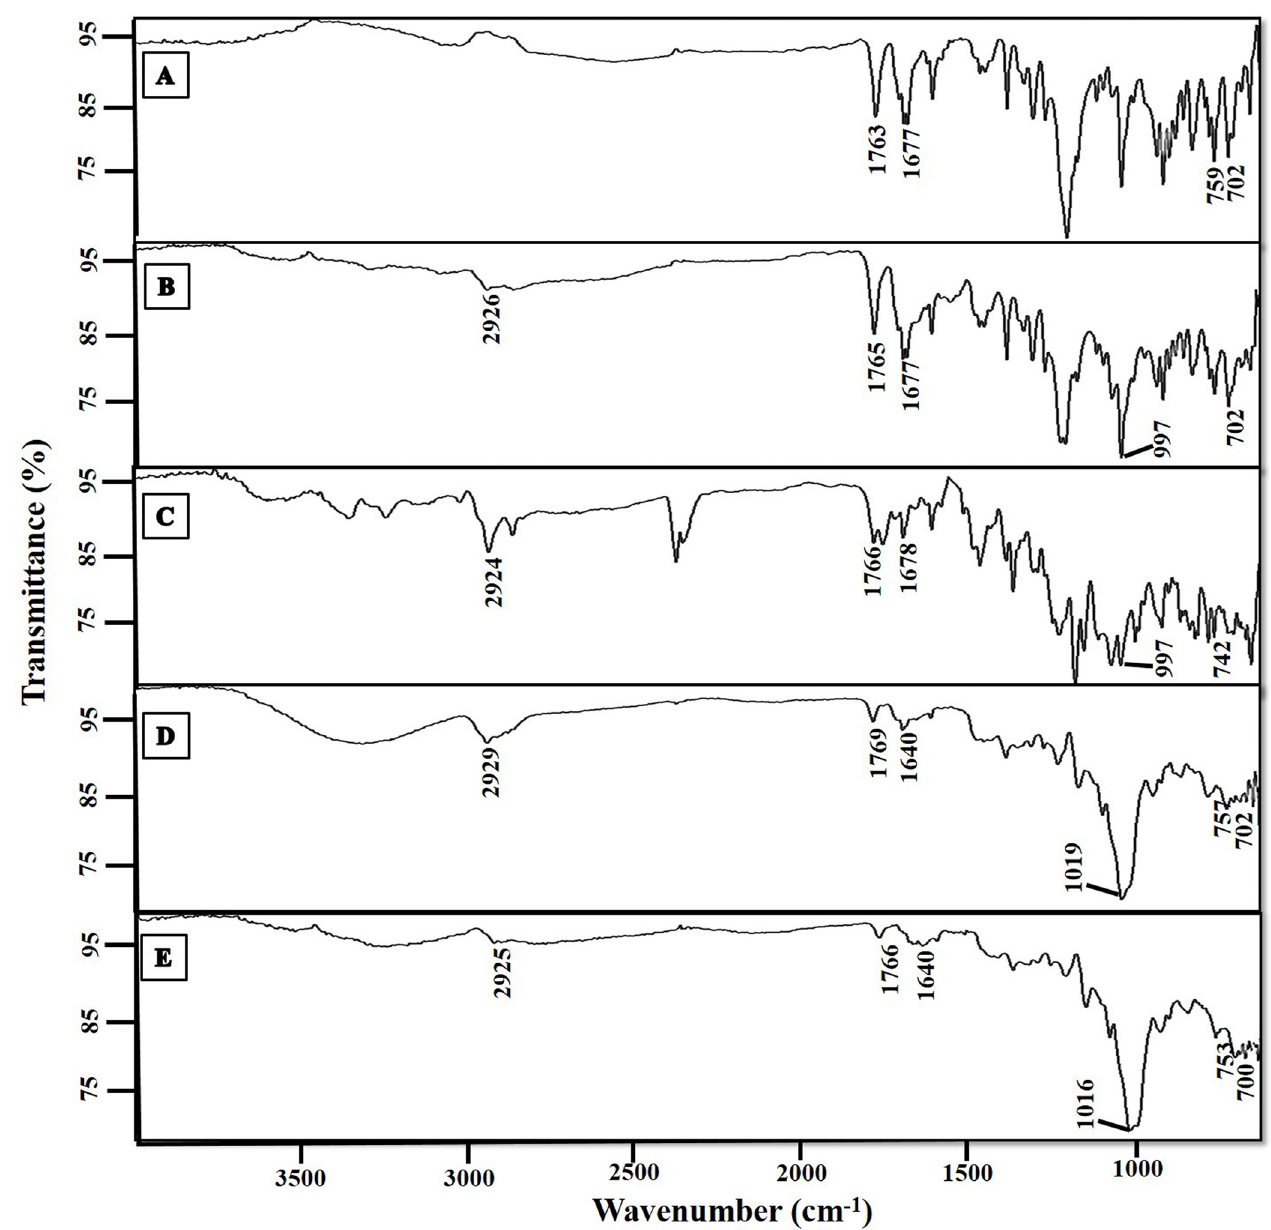
Fig 2. FTIR analysis of diacerein (A), egg lecithin based physical mixture (B), soy lecithin based physical mixture (C), D5PL (D) and D11PL (E). lecithin based physical mixture showed peaks at 2924 cm -1 (2921cm -1 of lipid), 1766 cm -1 (1763 cm -1 of diacerein), at 1678 cm -1 (1677 cm -1 of diacerein), at 997 cm -1 (997 cm -1 of malto- dextrin) and at 742 cm -1 (753 cm -1 of diacerein). The egg lecithin based formulation (D5PL) showed peaks at 2929 cm -1 (2921 cm -1 of leci- thin), 1769 cm -1 (1763 cm -1 of diacerein), at 1019 cm -1 (997 cm -1 of maltodextrin as peak shifted to slightly high intensity) at 757 cm -1 (759 cm -1 of diacerein) and at 702 cm -1 (702 cm -1 of diacerein) respectively. Likewise, the soy lecithin based formulation (D11PL) showed peaks at 2925 cm -1 (2921 cm -1 of lecithin), 1766 cm -1 (1763 cm -1 of diacerein), at 1016 cm -1 (997 cm -